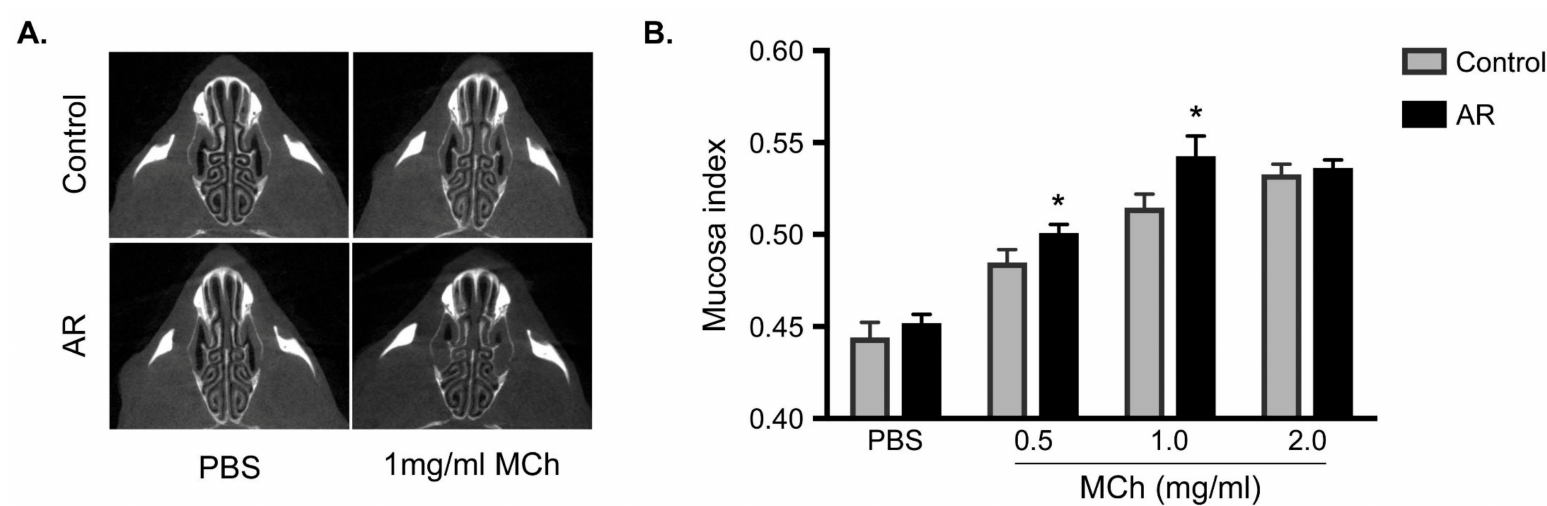
Figure 3. Increase in the mucosa index in OVA-induced allergic rhinitis (AR). ( A ) indicates raw axial micro-CT image at 15 min after PBS or 1 mg / mL MCh treatment in control (upper panel) and OVA-induced AR group (lower panel). ( B ) Mucosa index is shown 15 min after PBS or 0.5–2 mg / mL MCh treatment in control (gray bar) and AR (black bar) groups. Data are expressed as means ± SEMs ( n = 5 for each group). * Significantly di ff erent from control mice ( P < 0.05).